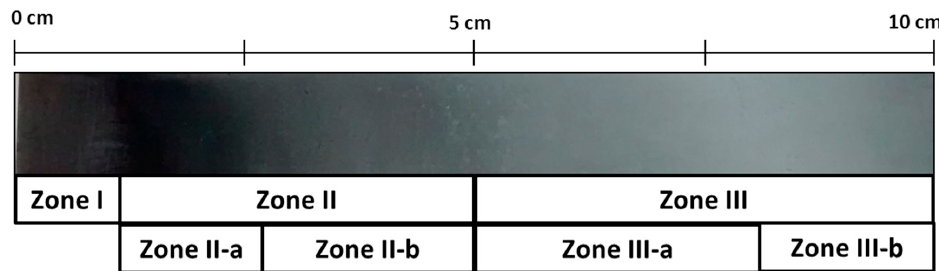
Figure 3. Macrophotography of a Hull cell specimen obtained in 0.3 M ZnCl 2 –0.1 M CeCl 3 –ChCl–Urea with the different color zones indicated. with the different color zones